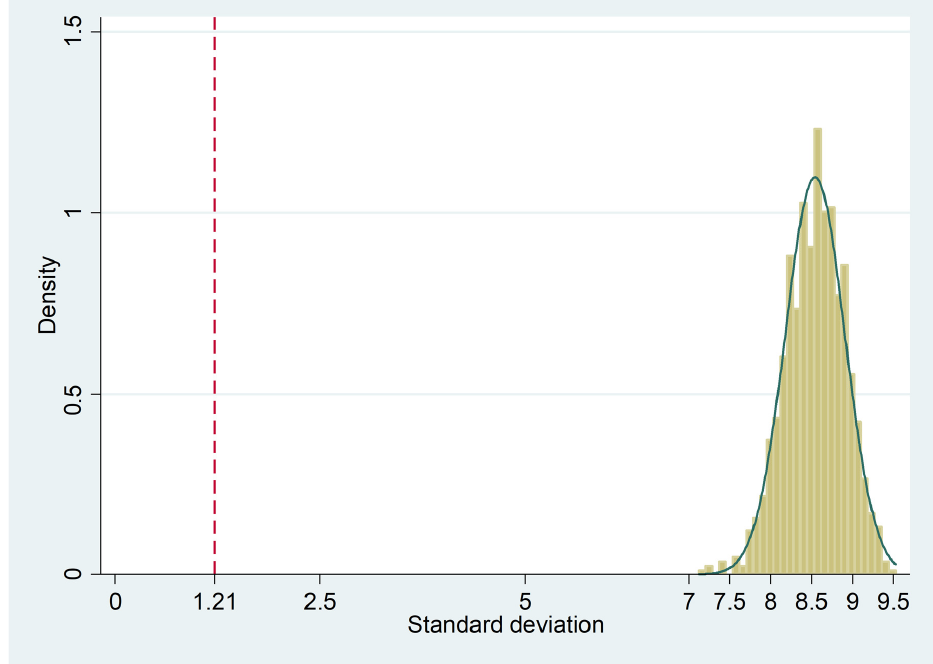
Figure 4. Distribution of the standard deviation from 1000 random mispairings according to the 1 Preiss-Fisher procedure [34]. The observed standard deviation in the interrater sample (1.21) is clearly smaller than the minimum of the standard deviations from 1000 random mispairings